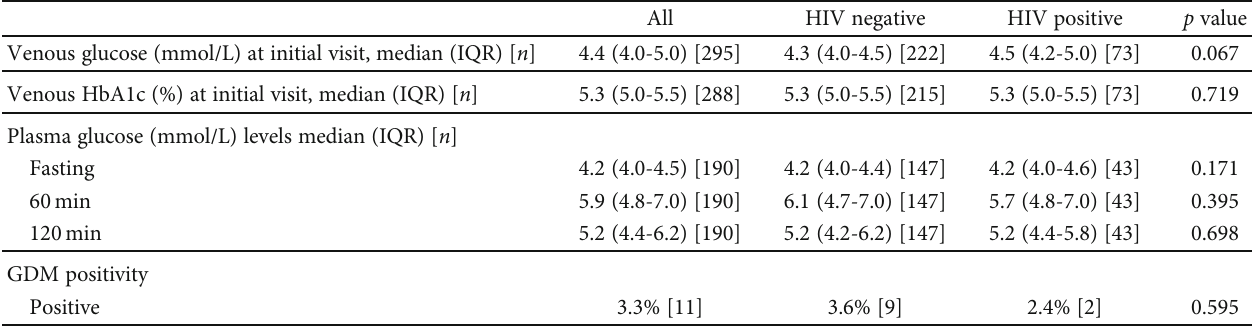
Table 3: Glucose measurements at the oral glucose tolerance test visit between 24 and 32 weeks.